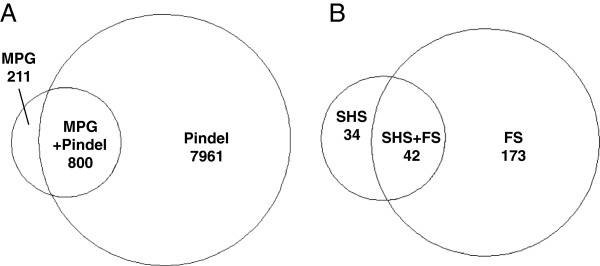
Overlap of indel determinations. (A) Overlap between indels identified using MPG or Breakdancer/Pindel to analyze FS data. (B) Overlap between the same sample using SHS(MPG) and FS(Breakdancer/Pindel), limited to the demoX region + 100 bp.